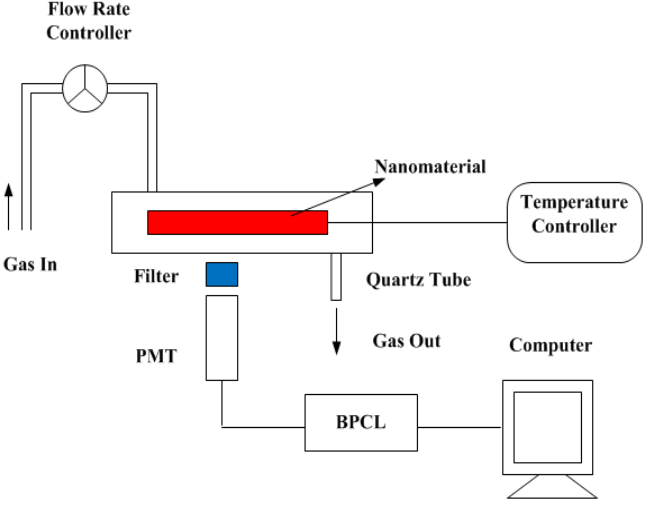
Figure 3. Schematic diagram of the CTL sensor array